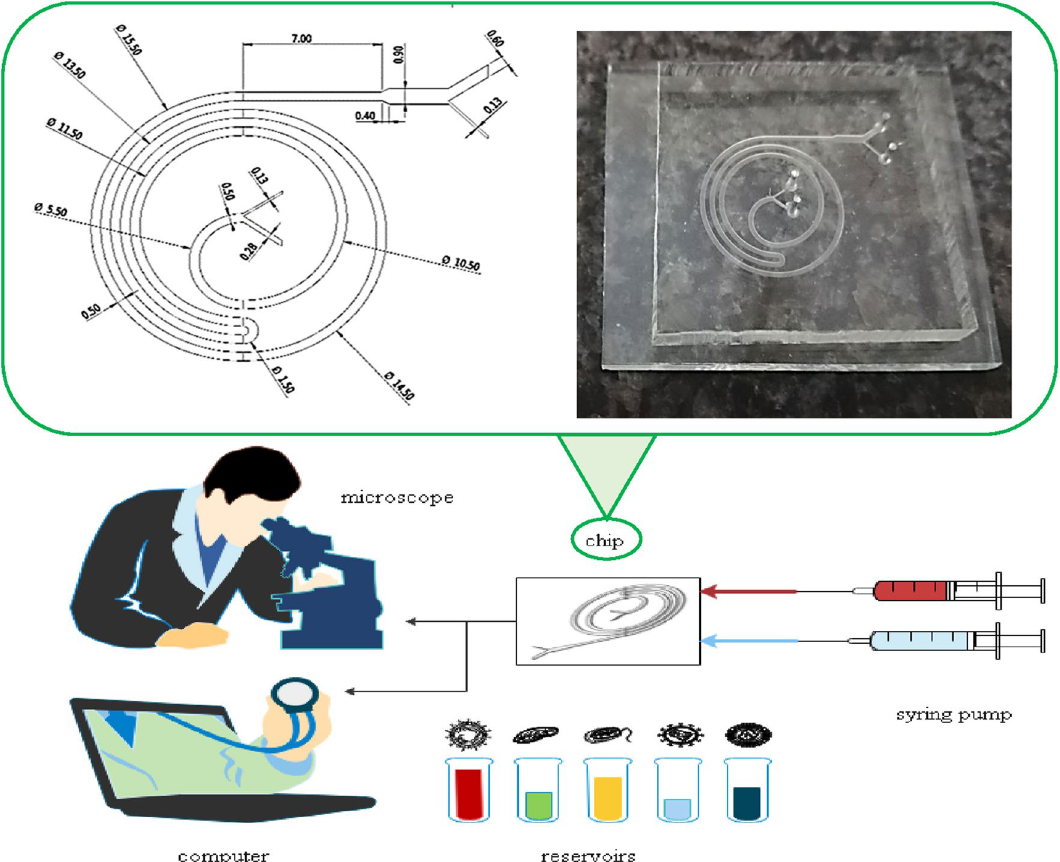
Figure 3. Microchannel geometric pattern with full details, and Schematic of the setup designed for experimental